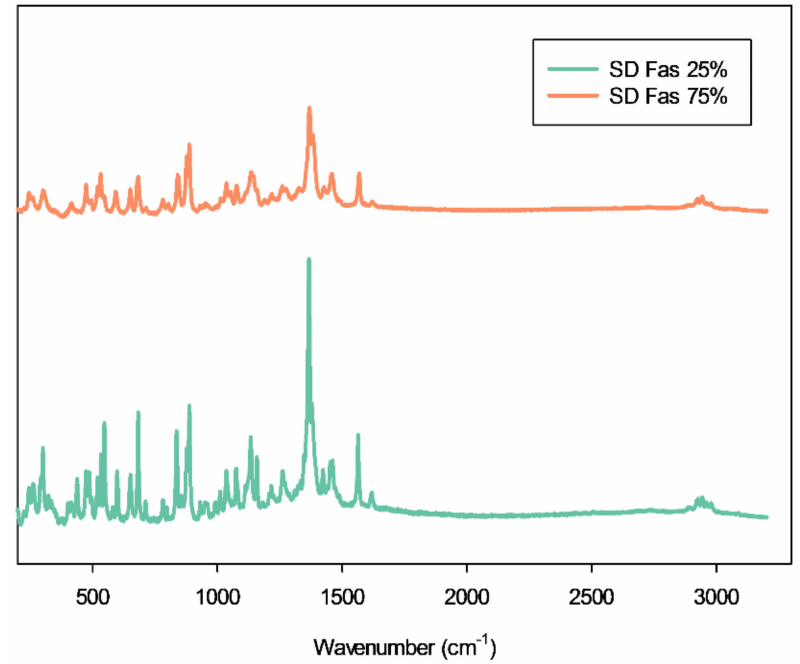
Figure 7. Representative Raman spectra of selected SD FAS formulations obtained using 785 nm